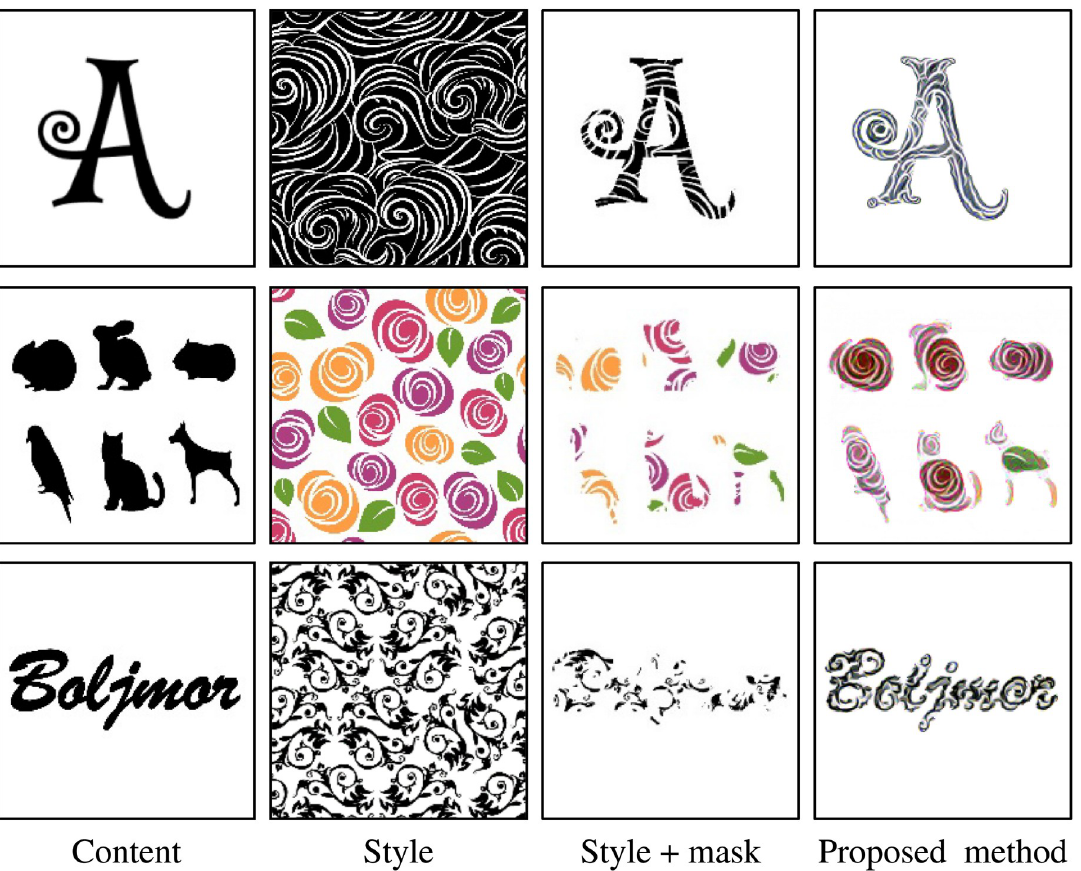
Fig 11. Comparison of the proposed method against masking the style